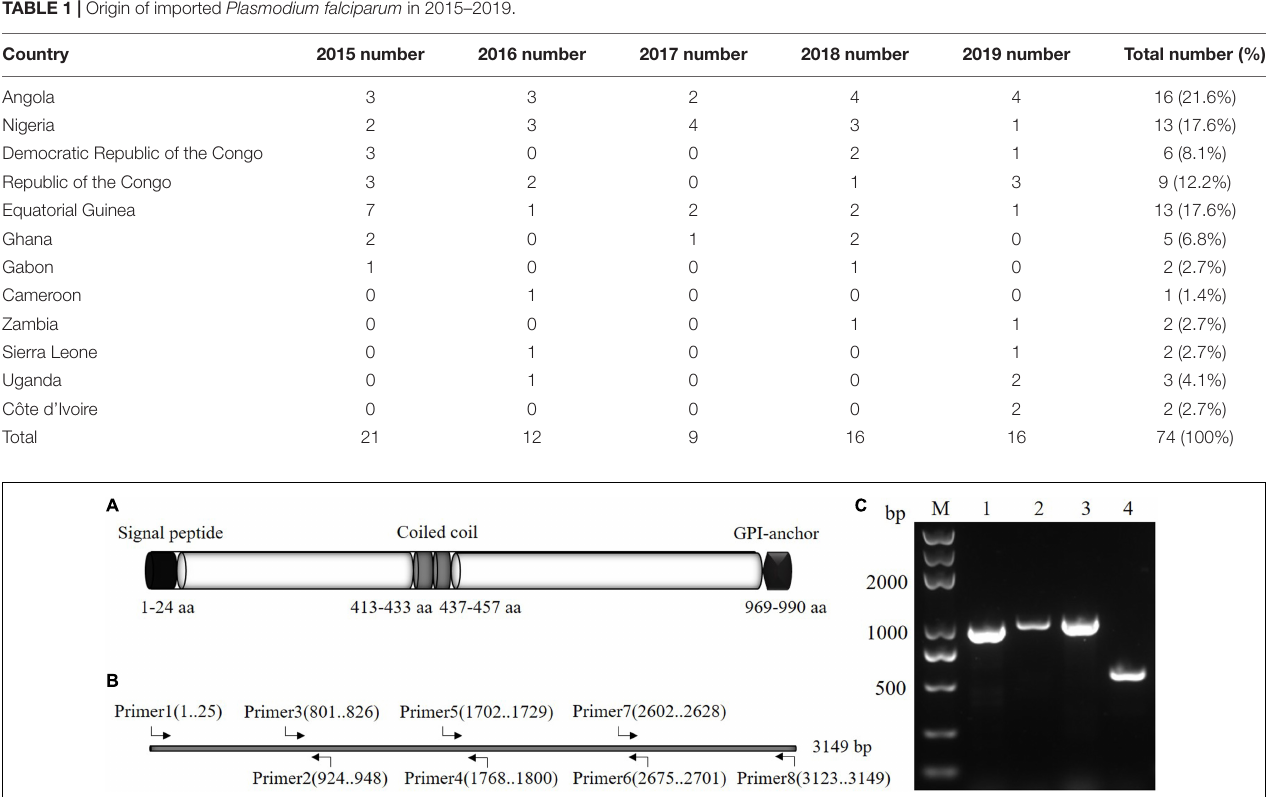
FIGURE 2 | Predicted P. falciparum SRA protein primary structure and primer design diagram. (A) Diagram of PfSRA protein primary structure. (B) Diagram of pfsra primers design. (C) Amplification of four fragments of pfsra by PCR. Abbreviations: M, DNA marker; 1, the first fragment of pfsra (948 bp); 2, the second fragment of pfsra (1 kb); 3, the third fragment of pfsra (1 kb); 4, the fourth fragment of pfsra (548